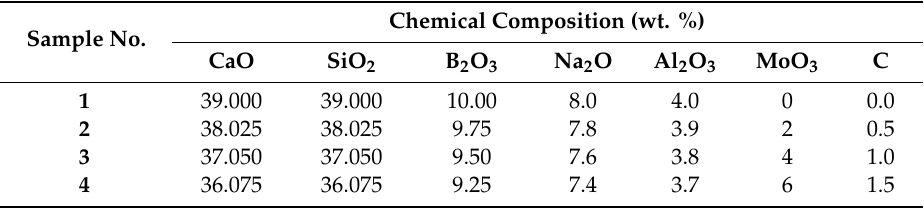
Table 1. Chemical composition of the studied slag